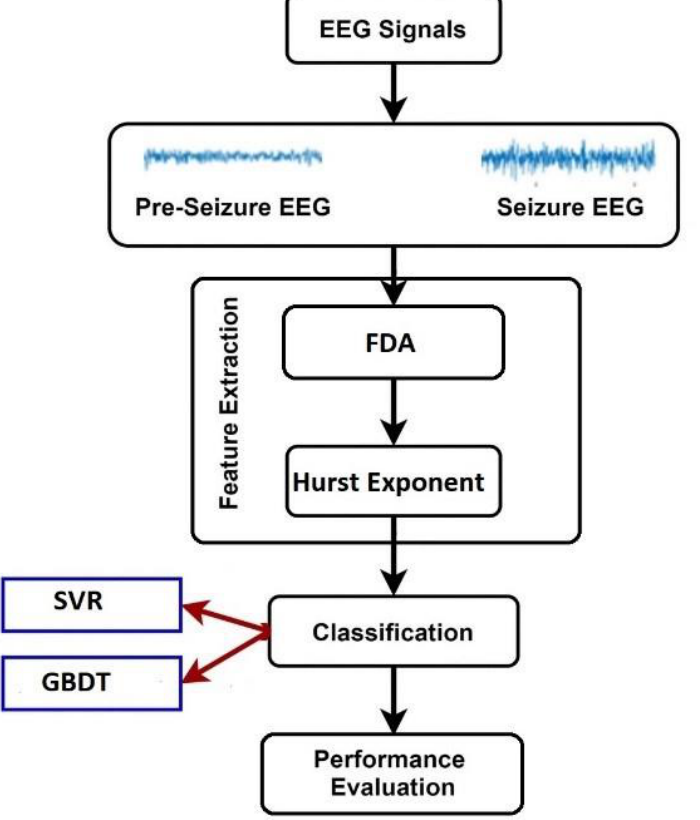
Figure 1. The Architecture of FDA and